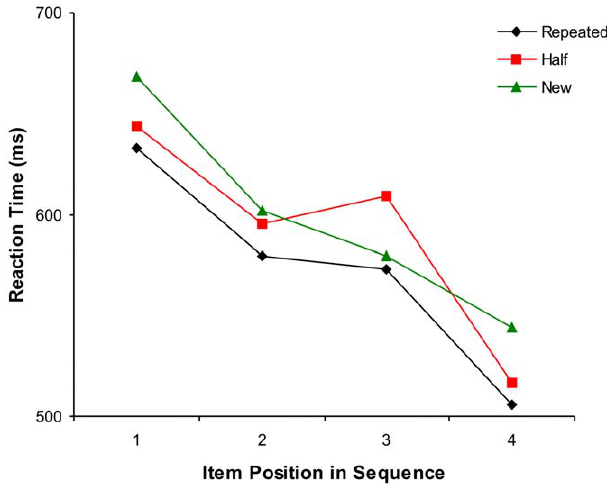
Figure 5. Results of Experiment 2 (Behavioral): RT Cost of the Violation of Prior Expectations in the S half Condition During this experiment, a separate group of naive subjects performed a speeded semantic categorization task (see Materials and Methods). There was a significant effect of sequence type (i.e., collapsed across item position), with subjects fastest in the S rep condition (black diamonds), reflecting the utility of sequential predictions based on a single prior experience (i.e., first presentation: see Results for details). Critically, a significant RT cost was observed in the S half condition (red squares) at thethird item position, when prior predictions are violated by sensory reality. Note, no error bars are displayed because reported statistical comparisons reflect within-subject effects (as opposed to the condition- specific between-subject variance measure represented by bars). Green triangles indicate S new